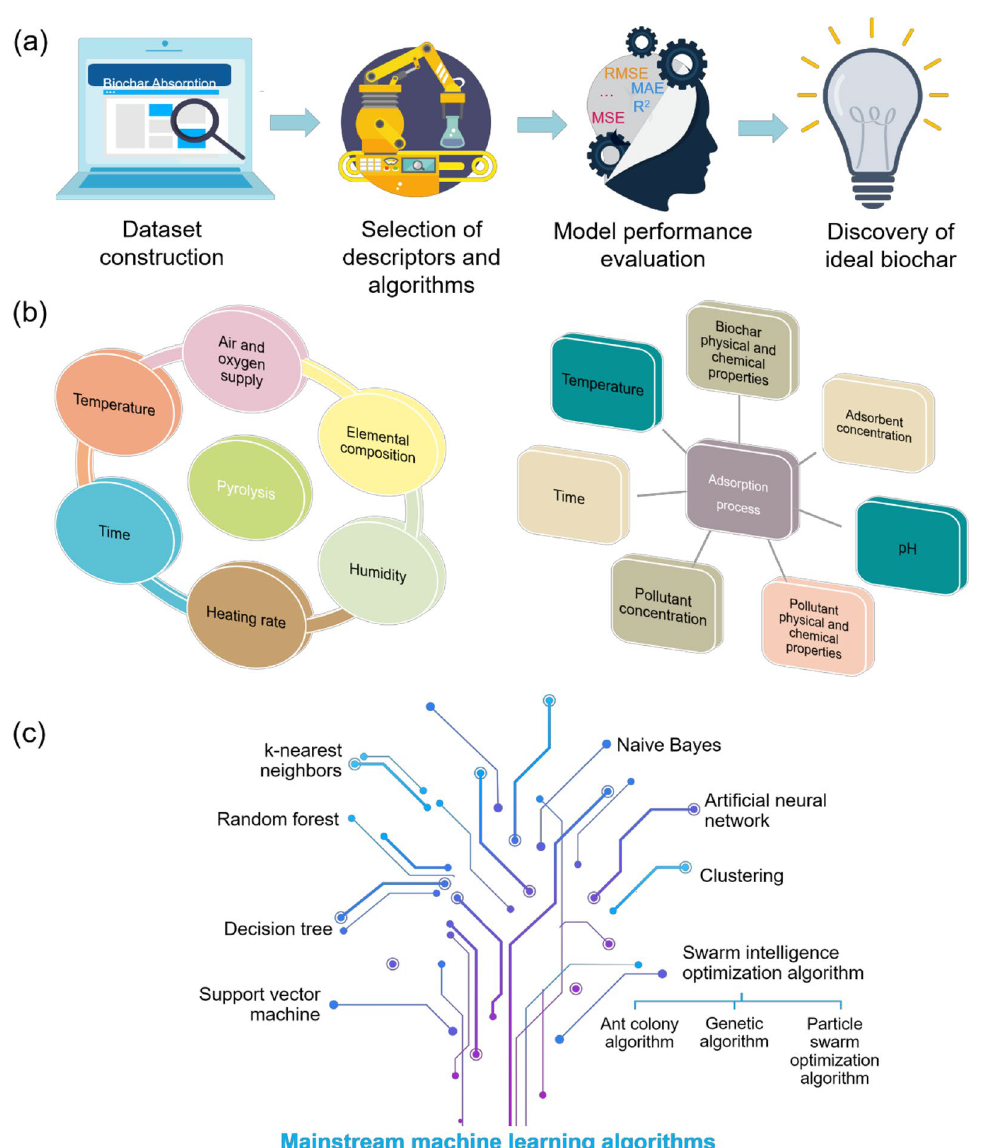
Fig. 2 a General workflow of machine learning for optimizing synthesis and pollutant adsorption processes of biochar; b The variety of descriptors for optimizing biochar pyrolysis (Left) and adsorption (Right) processes; c Mainstream algorithms for optimizing synthesis and adsorption processes of biochar for pollutant